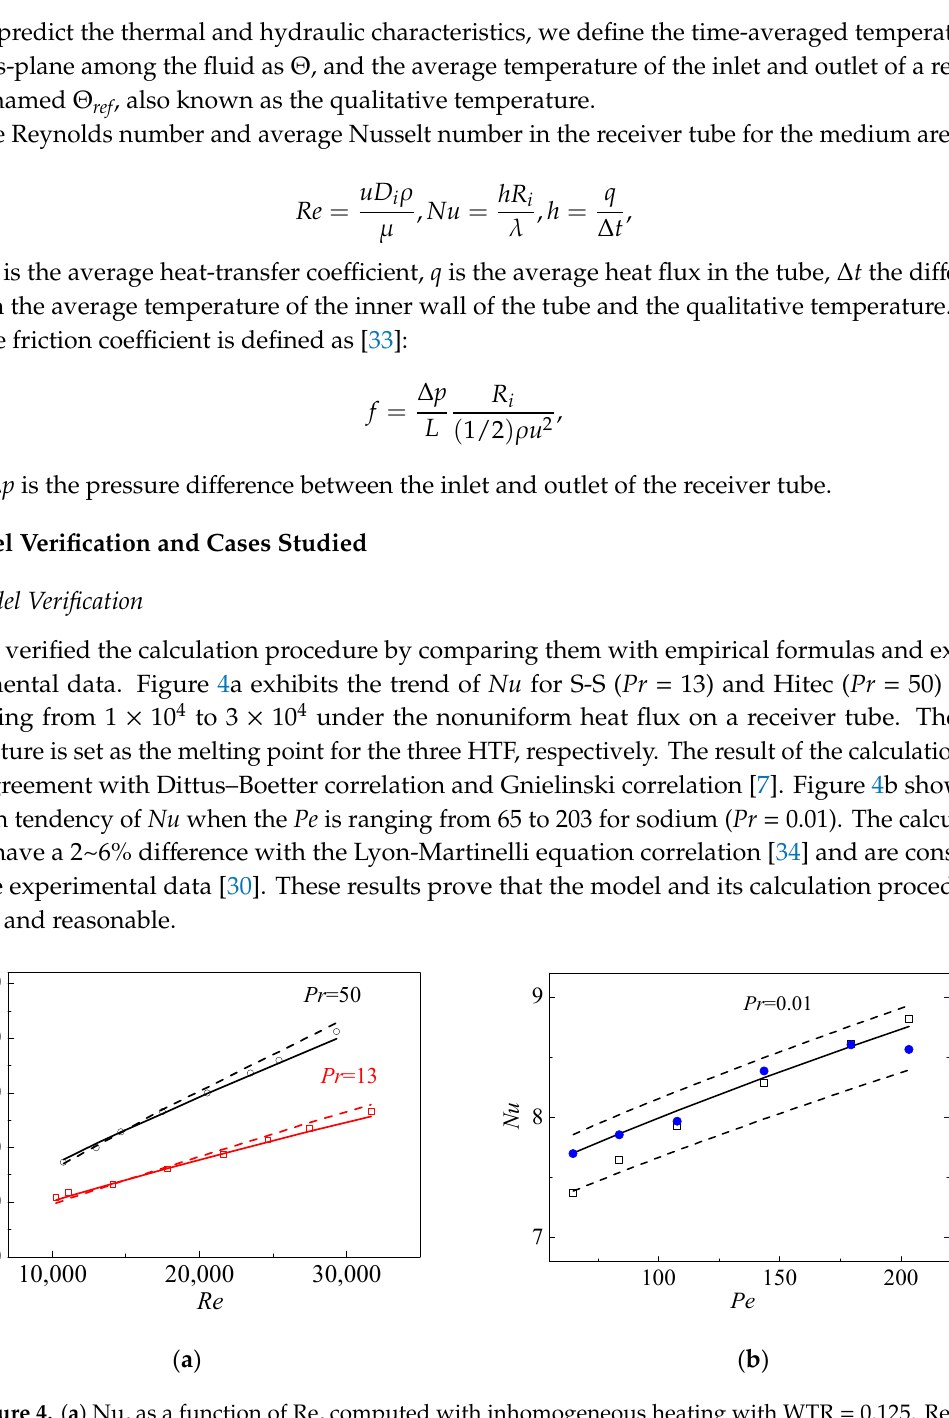
Figure 4. ( a ) Nu, as a function of Re, computed with inhomogeneous heating with WTR = 0.125. Red squares: Pr = 13. Black circles: Pr = 50. Solid lines: Dittus–Boetter correlation. Dashed lines: Gnielinski correlation. ( b ) Nu, as a function of the Péclet number, Pe. Solid lines: Lyon-Martinelli correlation (Nu = 7 + 0.028 · Pe 0.8 ). Dashed lines refer to 2~6% from the correlation. Blue points: experimental data [34]. Black squares: numerical results.